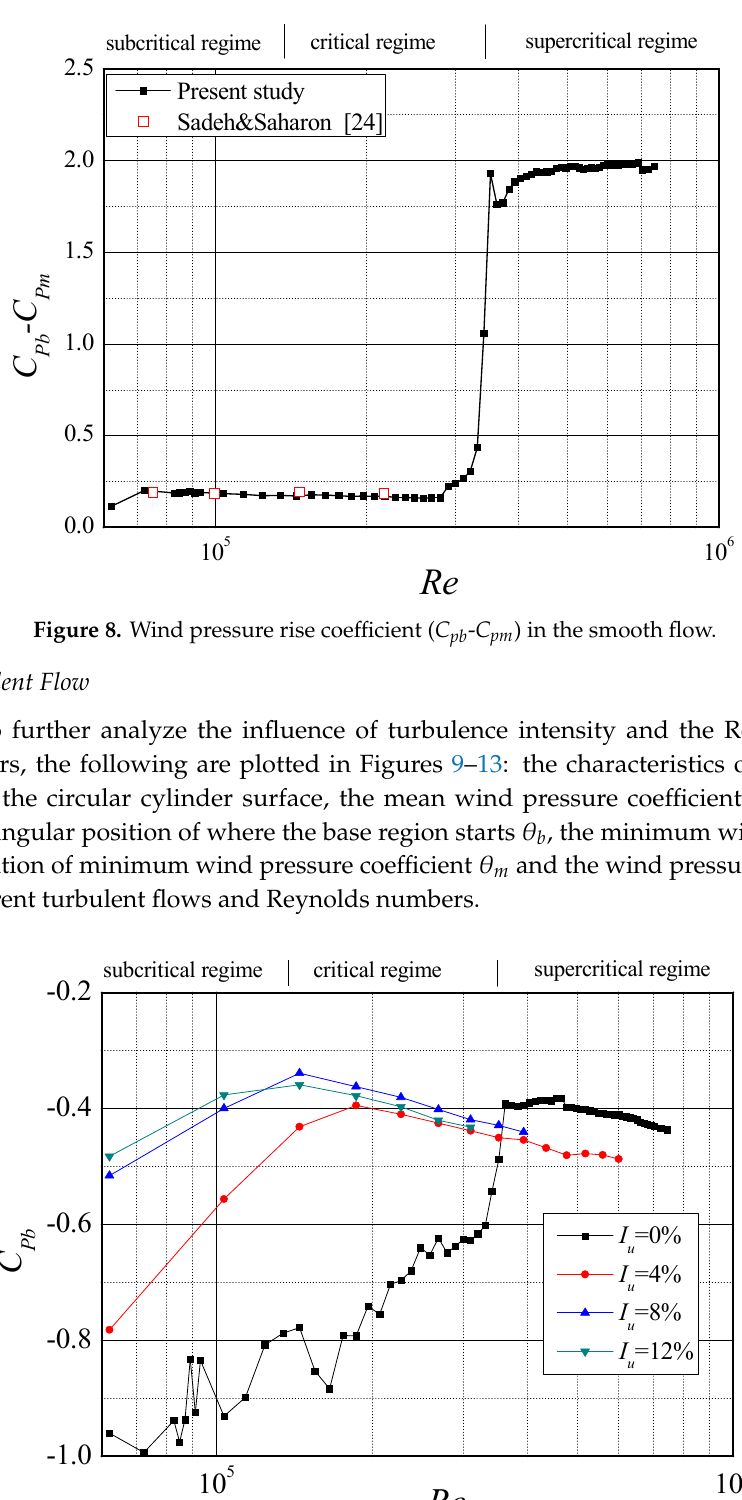
Figure 10 . The angular position of where the base region starts θ b in the turbulent flow. Figure 11 shows C pm for different turbulence intensities and Reynolds numbers. In the smooth flow, C pm is almost unchanged in the subcritical regime and suddenly decreases in the critical regime. However, it changes little in the supercritical regime. In the turbulent flow, when the Reynolds number is less than 2 × 10 5 , C pm decreases with the increasing Reynolds number and decreases with stronger turbulence intensity at the same Reynolds number. When the Reynolds number is larger than 2 × 10 5 , C pm has very minor changes. When the Reynolds number is greater than 3.3 × 10 5 , C pm is basically unchanged and is close to the value in the smooth flow. Figure 12 is θ m for different turbulence intensities and Reynolds numbers. In the subcritical regime, turbulence leads to an increase of θ m . In every turbulent flow in this paper, within the regime of measured Reynolds number, θ m is basically unchanged when the Reynolds number reaches a certain value—such as 1.9 × 10 5 —in turbulent flows of 8% and 12%. There is a significant difference in θ m when the Reynolds number is between 1 × 10 5 and 3 × 10 5 .